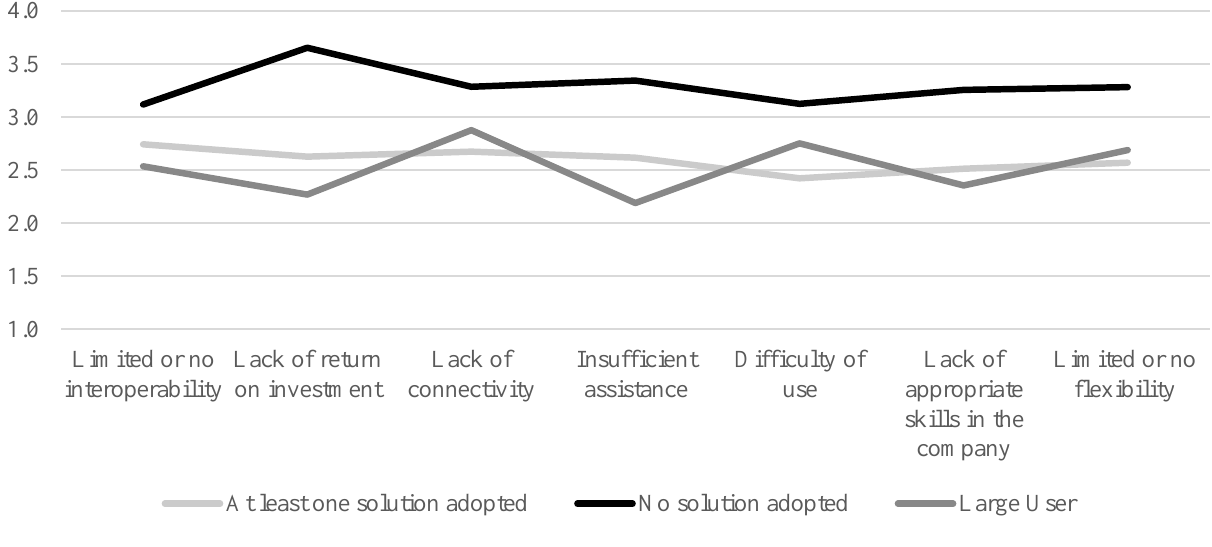
Figure 14. Challenges with Agri 4.0 solutions.